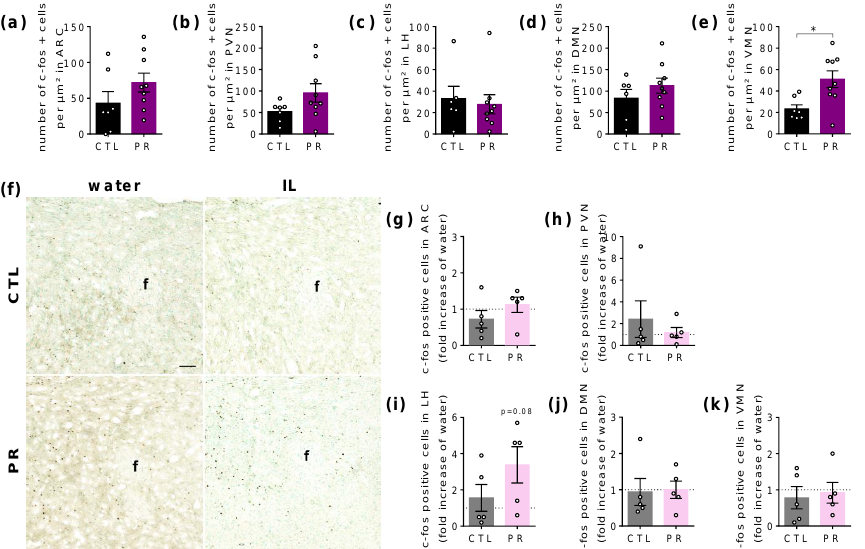
Figure 7. Immunostaining of c-fos-positive cells in hypothalamic nuclei after 1 h water or Intralipid 5% (IL) ingestion in female offspring at postnatal day (PND). Number of c-fos-positive cells in ARC ( a ), PVN ( b ), LH ( c ), DMN ( d ), and VMN ( e ) in CTL and PR females. Representative photomicro- graphs of lateral hypothalamus after water or IL ingestion in CTL and PR females ( f ). C-fos-positive cells in ARC ( g ), PVN ( h ), LH ( i ), DMN ( j ), and VMN ( k ) in fold increase of water CTL and PR females. Black and purple bars, water; grey and pink bars, IL. CTL, control. PR, protein restriction. IL, intralipid; ARC, arcuate nucleus; PVN, paraventricular nucleus; LH, lateral hypothalamus; DMN, dorsomedian nucleus; VMN, ventromedian nucleus; f, fornix. Scale bar = 100 nm. Data are individual values and mean ± SEM or individual values ( n = 4 – 5). * p < 0.05 vs. CTL, unpaired t-test. At basal state, the number of c-fos-positive cells differed only in the VMN, with a higher number in PR females ( p < 0.05; Figure 7e). The 1 h IL consumption, similar between CTL and PR females (CTL: 75.6 ± 15.2 kcal/kg; PR: 71.0 ± 5.8 kcal/kg), induced a c-fos- positive signal in the LH area of PR females that tended to be higher than in the basal state ( p = 0.08; Figure 7i). 4. Discussion This present study focused on the effect of maternal PR during gestation and lacta- tion on maternal parameters and offspring growth, metabolism, and food behaviour. There is considerable evidence that PR alters the hormone profile and lipid and glucose metabolism, with some discrepancies in the consequences for offspring feeding behav- iour. In addition, few studies have focused on the health of the mother during gestation